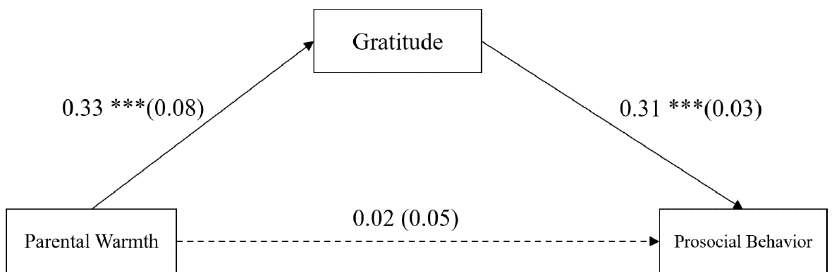
Figure 2. Model of the mediating role of gratitude between parental warmth and prosocial behavior. Values are unstandardized coefficients and the standard error. Paths between gender and age in the model are not displayed because none of these paths were significant. *** p < 0.001.